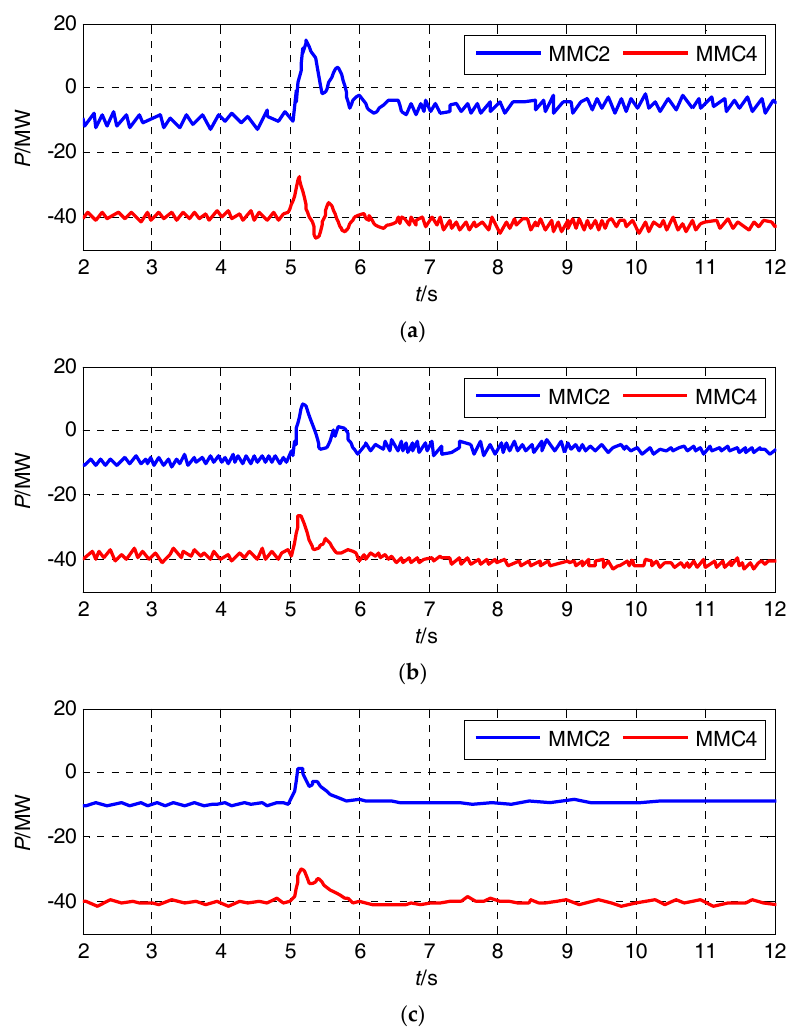
Figure 10. Simulation of the operation during an exit of an input converter station: ( a ) The active power of the receiving end controlled by DCLC; ( b ) the active power of the receiving end controlled by FCS ‐ MPC; ( c ) the active power of the receiving end controlled by HM 2 PC.